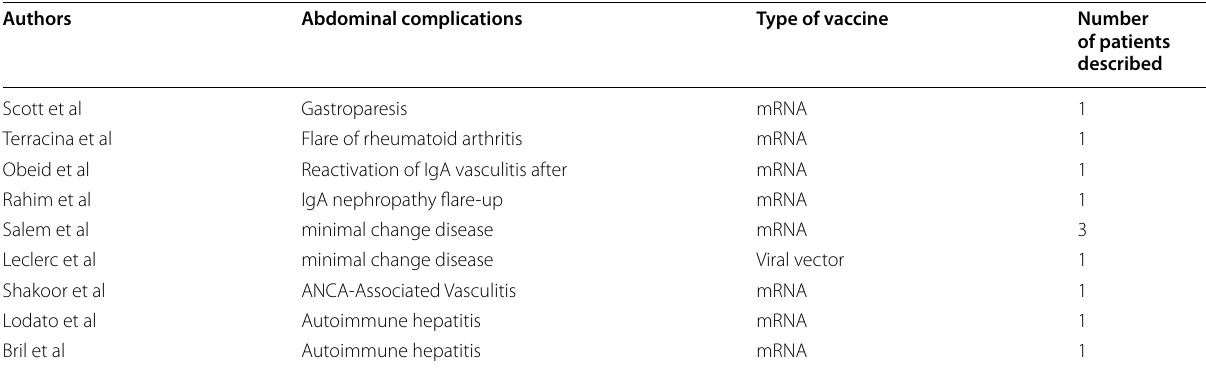
Table 4 Previous case-report about vaccine-related abdominal complications